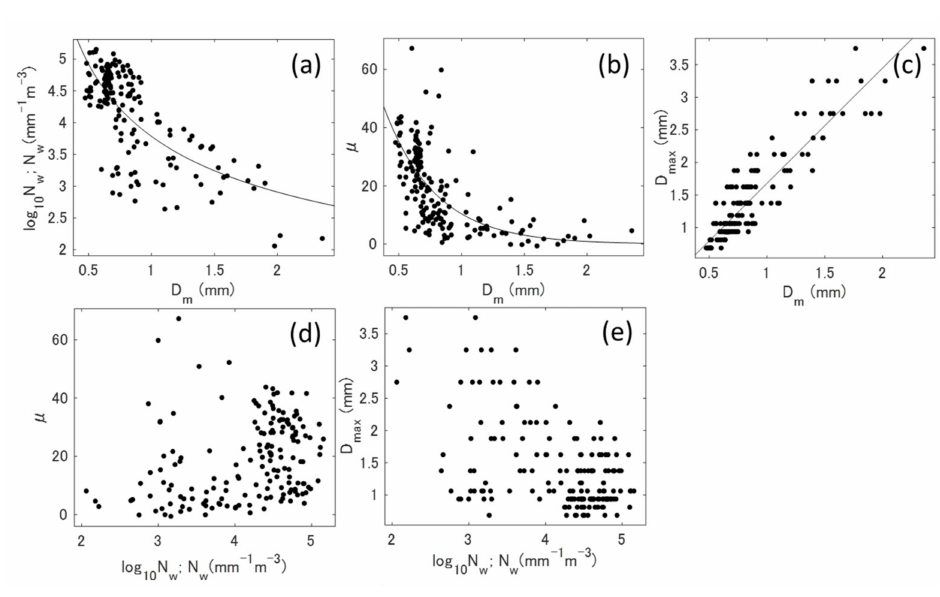
Figure 12. The same as Figure 9, but for normalized PSD parameters including ( a ) D m vs. log 10 N w , ( b ) D m vs. µ , ( c ) D m vs. D max , ( d ) log 10 N w vs. µ , and ( e ) log 10 N w vs. D max